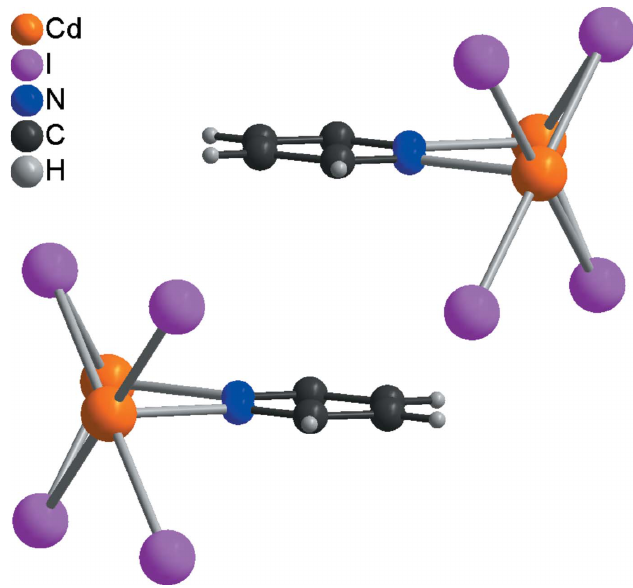
Figure 4 Arrangement of neighboring pyridazine rings in 1 showing (cid:3) – (cid:3) stacking